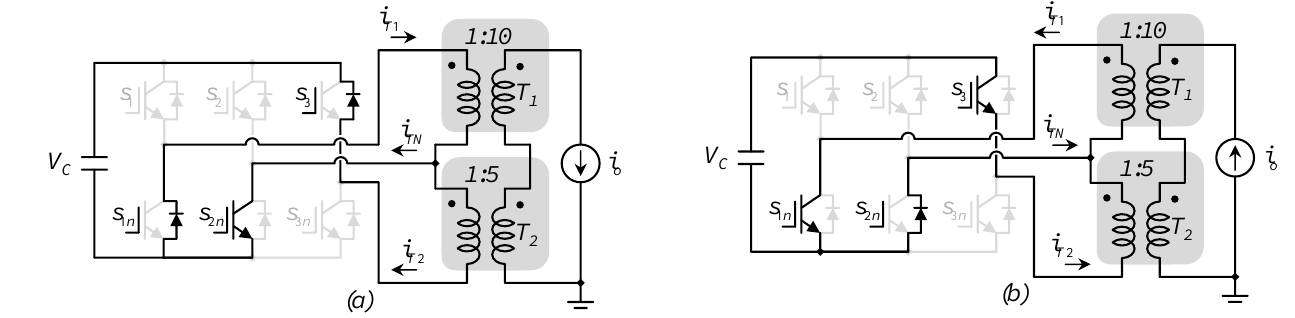
Figure 7. Current flow for different directions of the load current when s 1 = 0, s 2 = 0, and s 3 = 1. ( a ) when the load current is positive and ( b ) when the load current is negative.